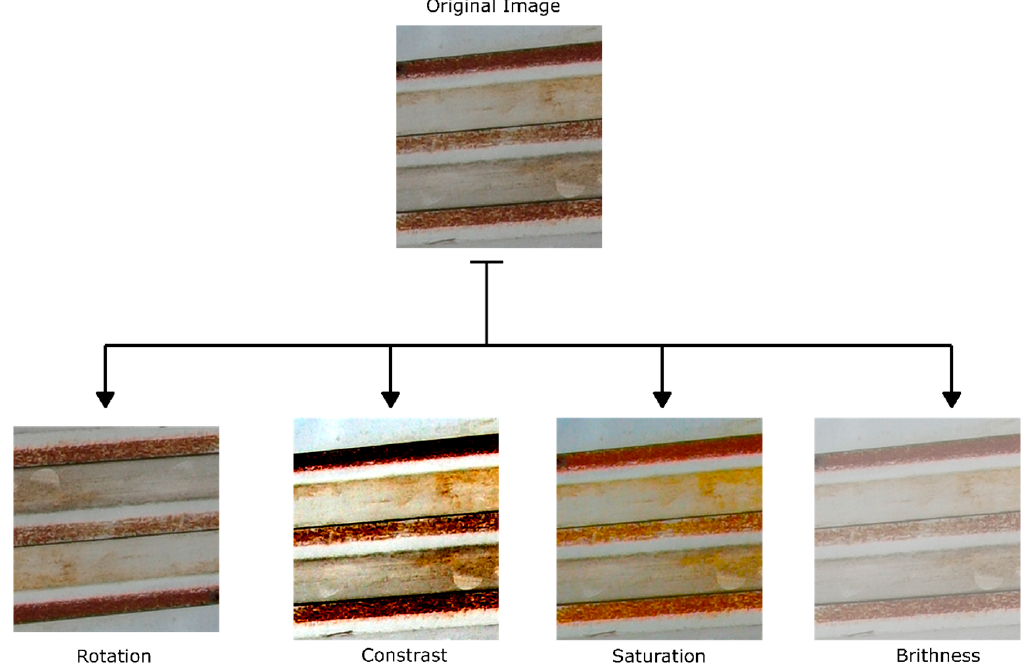
Figure 9. Data augmentation operations.